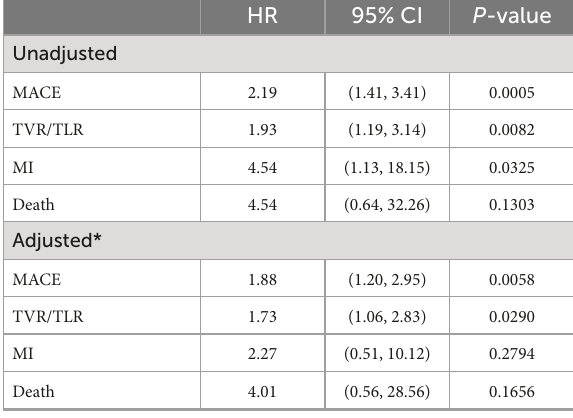
TABLE 2 Hazard ratios (HR) and 95% confidence interval (95% CI) for cardiovascular events according to testosterone level (testosterone ≥ 3.25 ng/mL as reference group) by cox